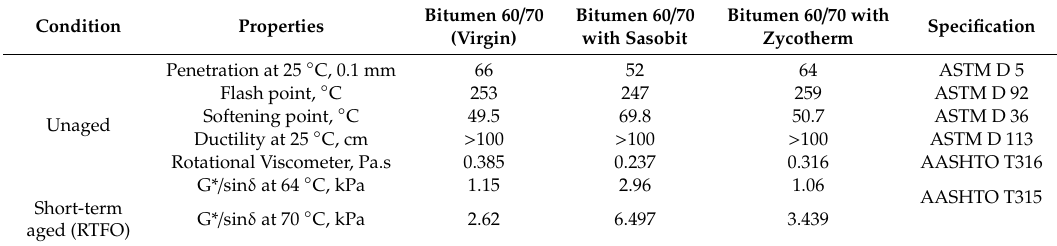
Table 2. Properties of bitumen 60 / 70, bitumen 60 / 70 with Sasobit, and bitumen 60 / 70 with Zycotherm.